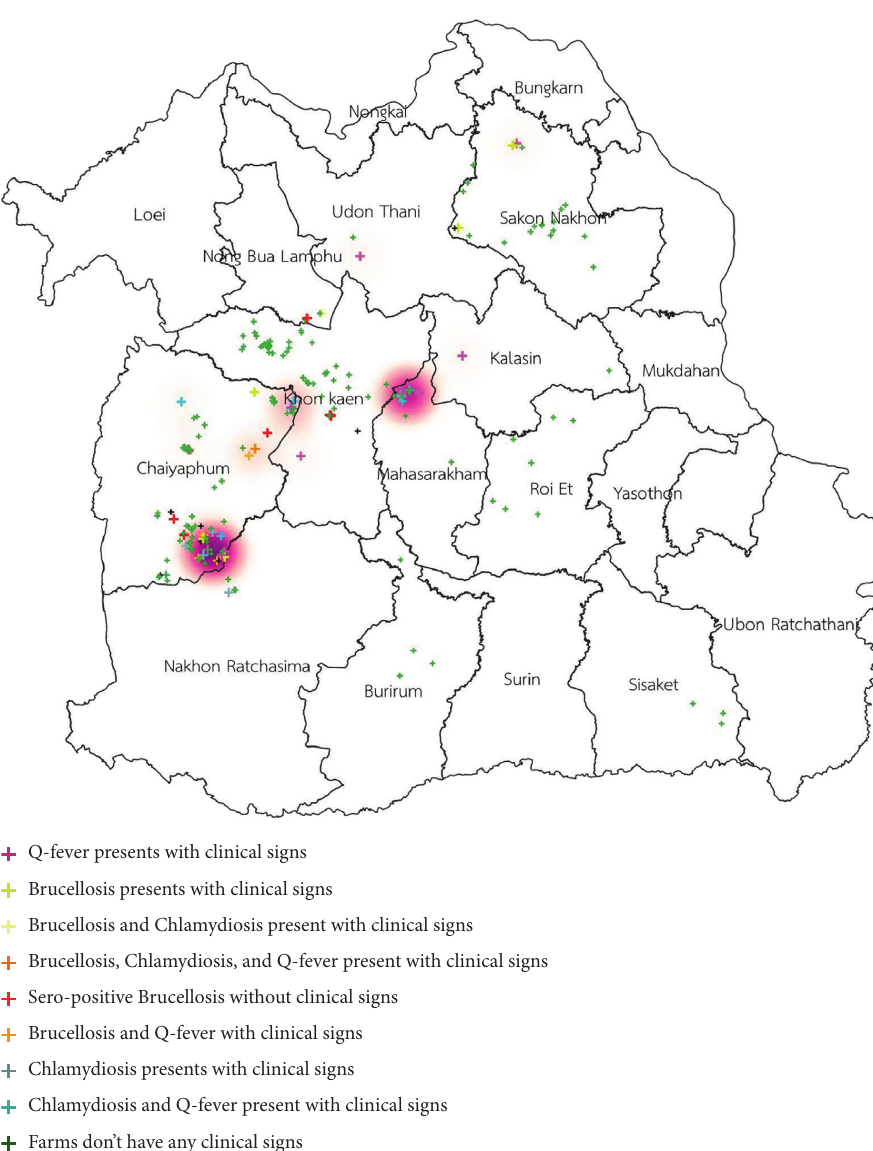
Figure 4: Distribution of clinical cases of Q fever in smallholder meat goat herds in northeastern